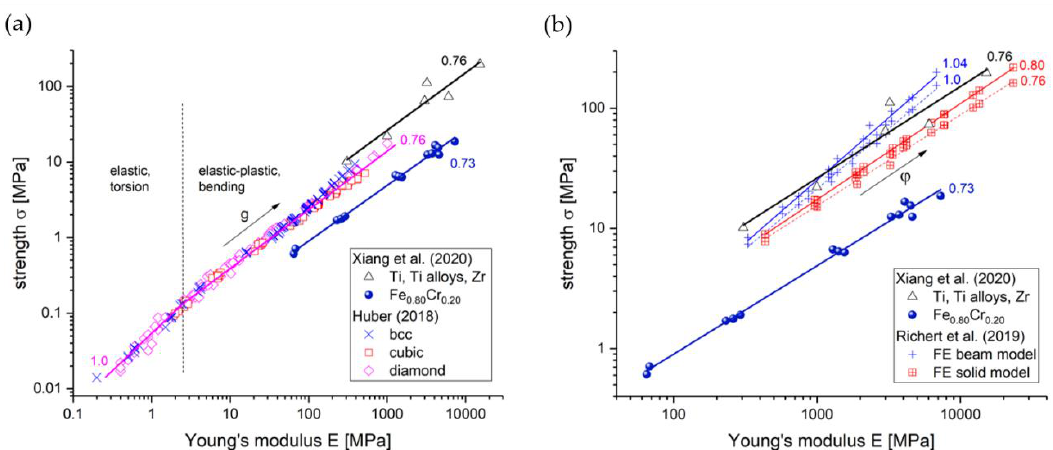
Figure 20. Comparison of the data published by Xiang et al. [14] with the data from ( a ) Huber [80], Supplementary material, Data sheet 2, and ( b ) comparison with the data from Richert et al. [53], Supplementary material, Tables S2 and S4 (thin dashed lines correspond to yield stress, thin solid lines are unpublished data and correspond to flow stress at 10% plastic strain). Slopes entered as numbers in the plots correspond to exponents n σ / n E in the dependency σ ∼ E n σ / n E .